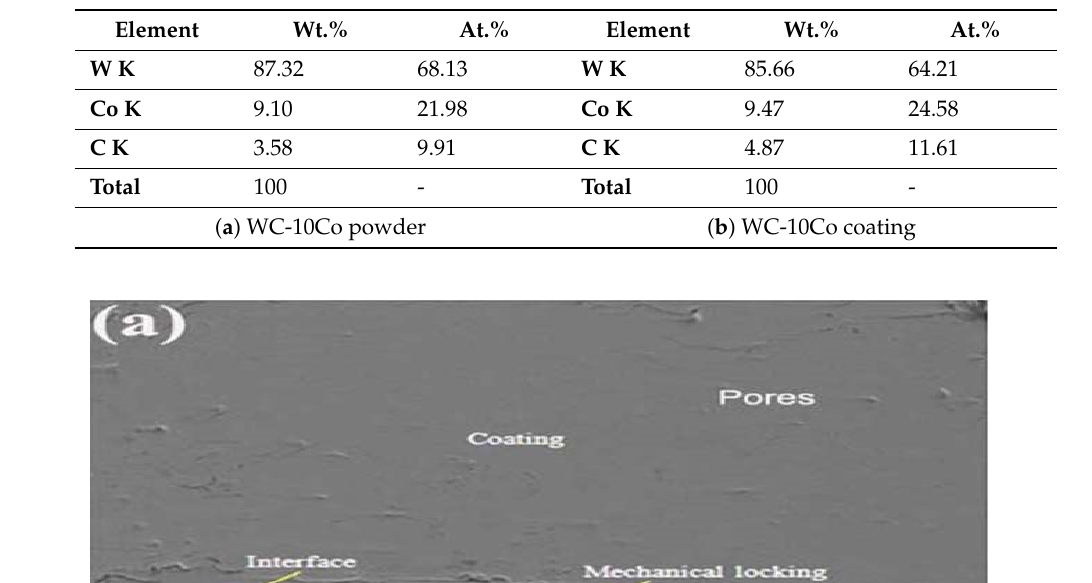
Table 2. EDS analysis of the WC-10Co powder and coatings.